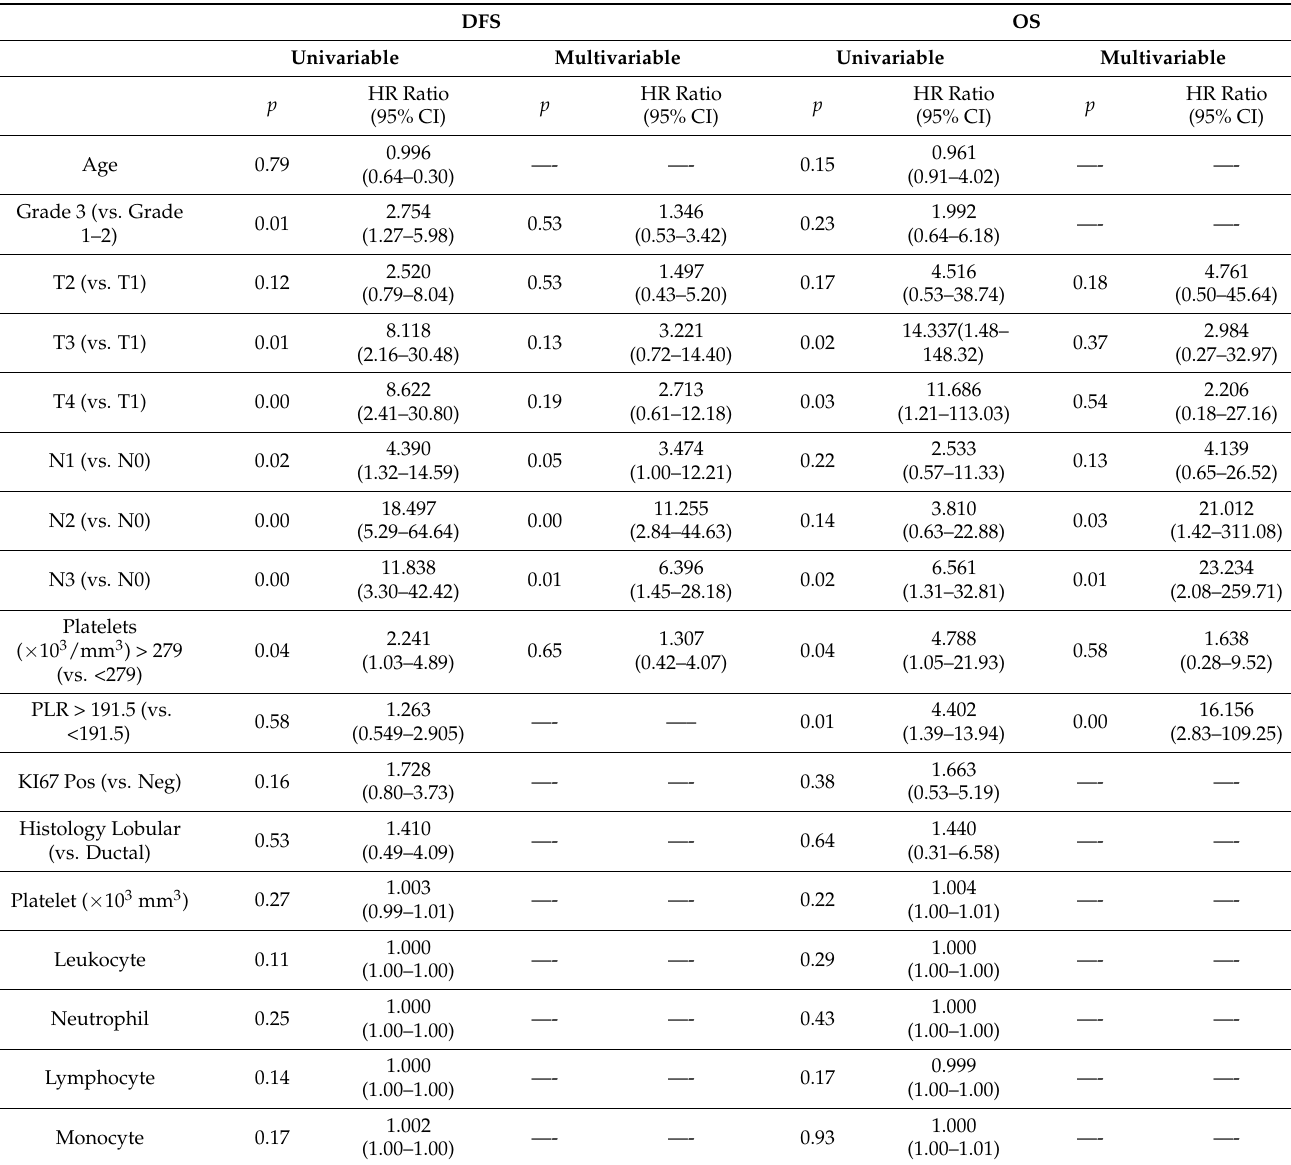
Table 4. Disease-free survival (DFS) and overall survival (OS) of patients with luminal breast cancer, based on the Cox regression analyses. DFS OS Univariable Multivariable